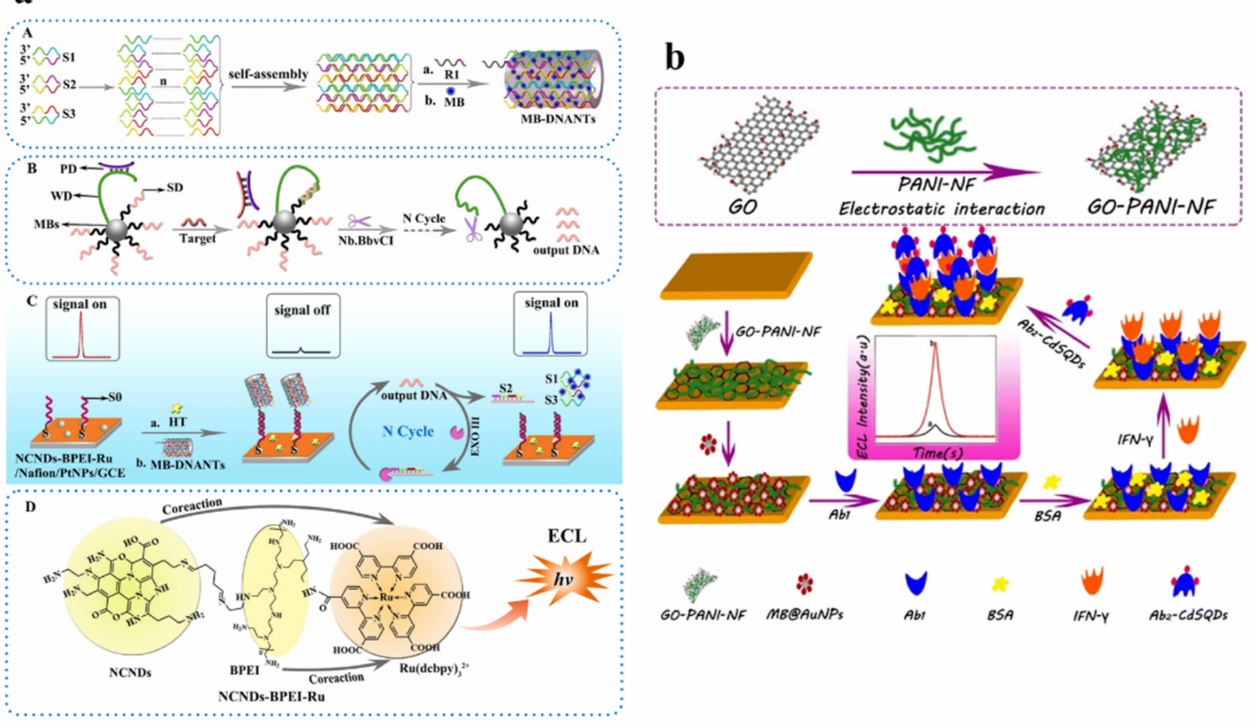
Figure 4. Schematic illustration of electrochemical biosensors fabricated with carbon nanomaterials for detection of Mycobacterium tuberculosis : ( a ) biosensors fabricated with self-assembled DNA nan- otubes embedded with methylene blue molecules (MB-DNANTs) and NCNDs-BPEI-Ru for detection of Mycobacterium tuberculosis [93]; ( b ) biosensor fabricated with gold nanoparticle-coated magnetic beads (AuNP@MB) attached on a nanofiber prepared from graphene oxide and polyaniline (GO-PANI- NF) for detection of IFN- γ related to latent infection of Mycobacterium tuberculosis [95]. ( a ) reproduced with permission Copyright 2021, Elsevier B.V. ( b ) Reproduced with permission Copyright 2016, Springer-Verlag